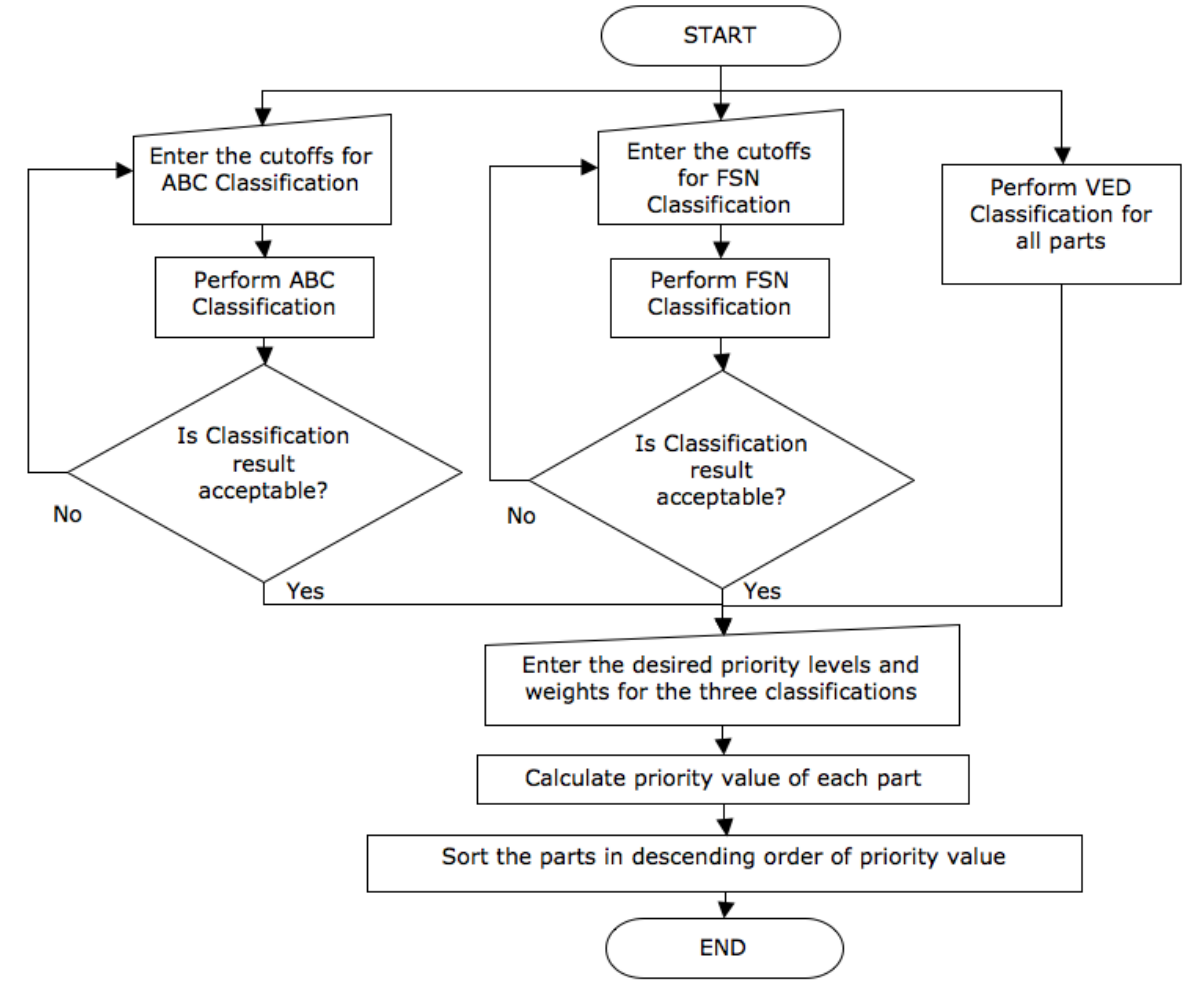
Figure 1. Integrated inventory ranking procedure